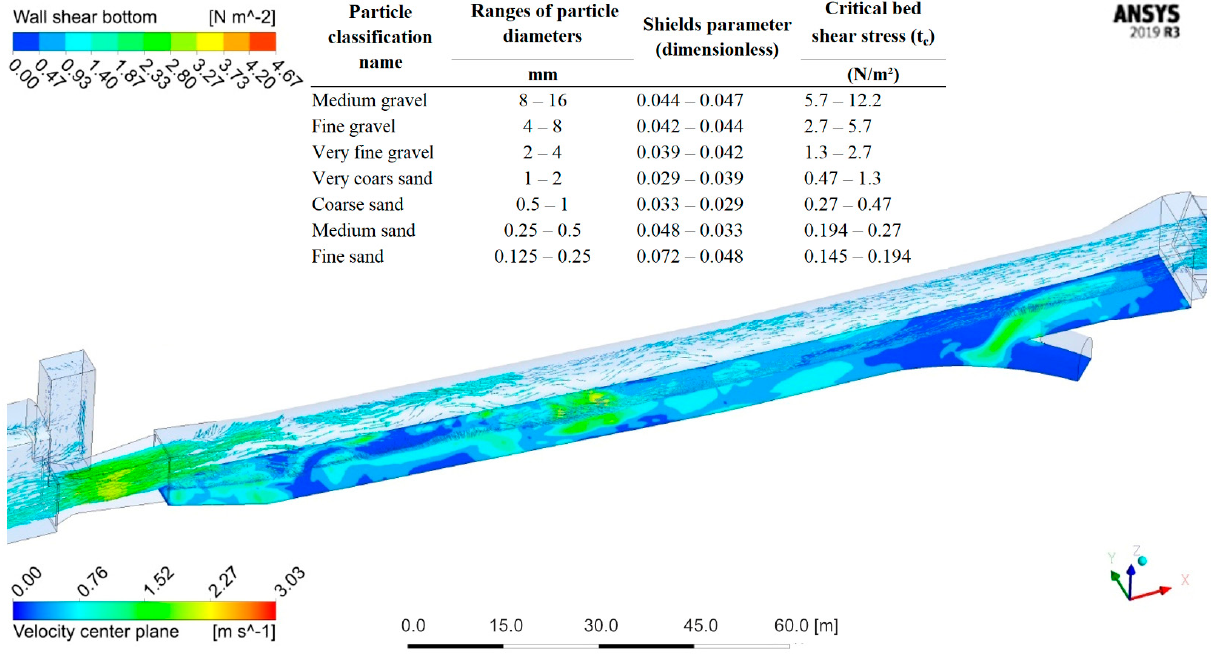
Figure 7. Geometry scale 1:1 with 80 m³/s discharge, velocity vectors in center plane and bottom wall shear stress, time step 189 s (flow through factor 0.79 [–]), and values of critical bed shear stress from [21].